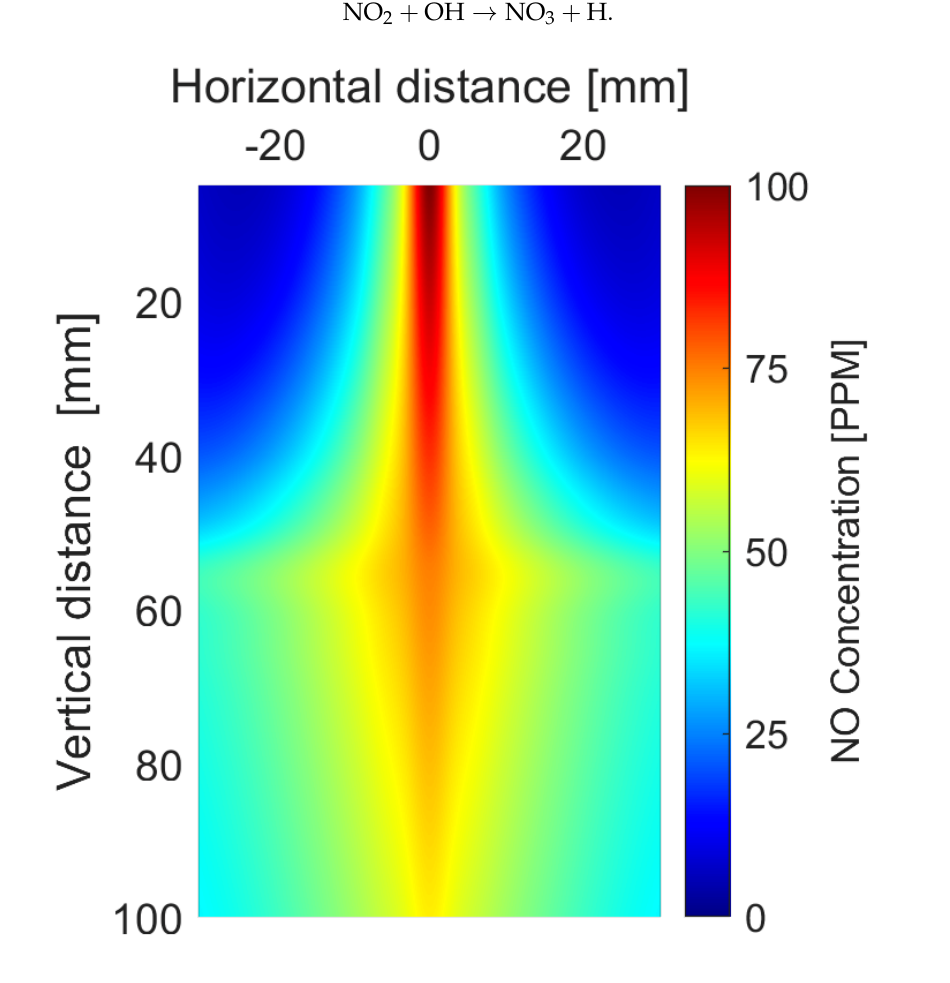
Figure 9. Spatial distribution of NO below the nozzle of the quartz tube. NO X is instantly liquefied, giving rise to the formation of NO − ically, H + is formed via the mechanism outlined in Equations (7)–(10), and this renders plasma-treated water acidic